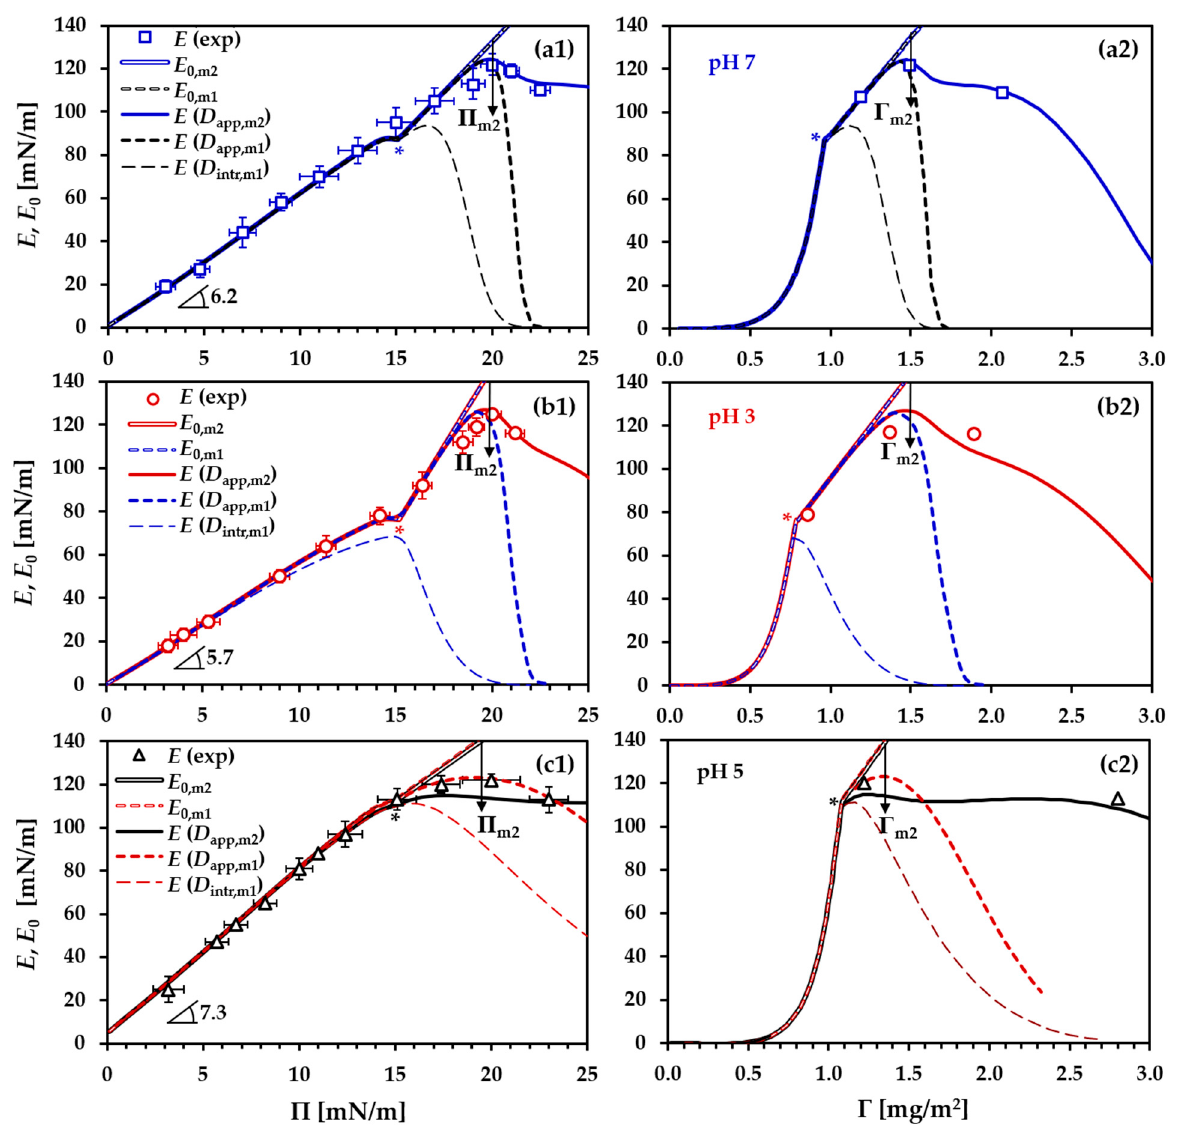
Figure 7. BLG adsorption layers at the water/air interface at ( a1,a2 ) pH 3, ( b1,b2 ) pH 7 and ( c1,c2 ) pH 5. Dependencies of the dilational complex viscoelasticity modulus E and the high-frequency limiting elasticity E 0 on ( a1,b1,c1 ) surface pressure, E 0 ( Π ) and E ( Π ) f,g and ( a2,b2,c2 ) surface excess, E 0 ( Γ ) and E ( Γ ) f,g ; f = 0.1 Hz, g ≈ 2.7%. Symbols are experimental data for E (exp), lines are best fits for one-layer (m1) and two-layer (m2) models (note the common legend for each row), asterisks indicate Π * and Γ *, arrows indicate the onset of secondary layer formation at Π m2 and Γ m2 , D intr = 1 × 10 − 10 m 2 /s, D app is the apparent diffusion coefficient with values listed in Table 2. Table 2. Values for the apparent diffusion coefficient, D app , used in the model calculations.